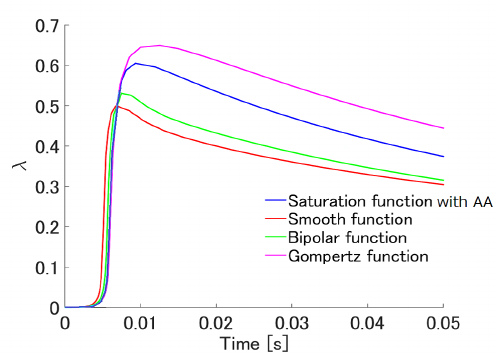
Figure 16. Enlarged view of time response of driving torque on wet asphalt (( 0 < t < 0 : 05 )